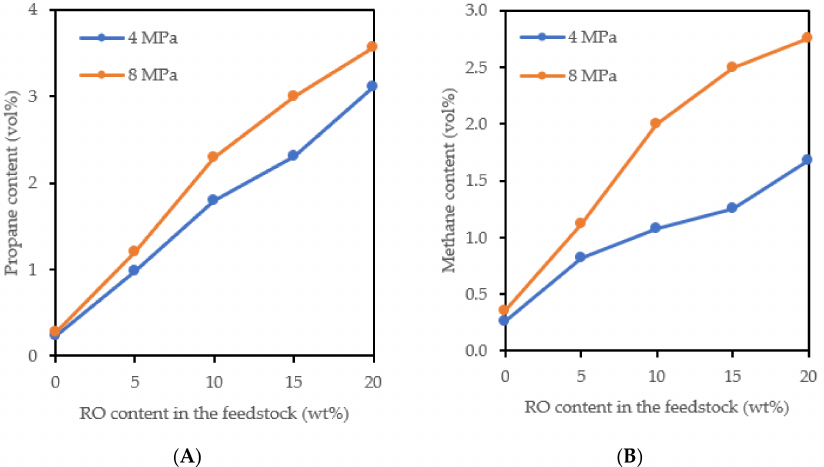
Figure 3. The content of propane ( A ) and methane ( B ) in the gaseous hydrotreated products (pressure of 4 and 8